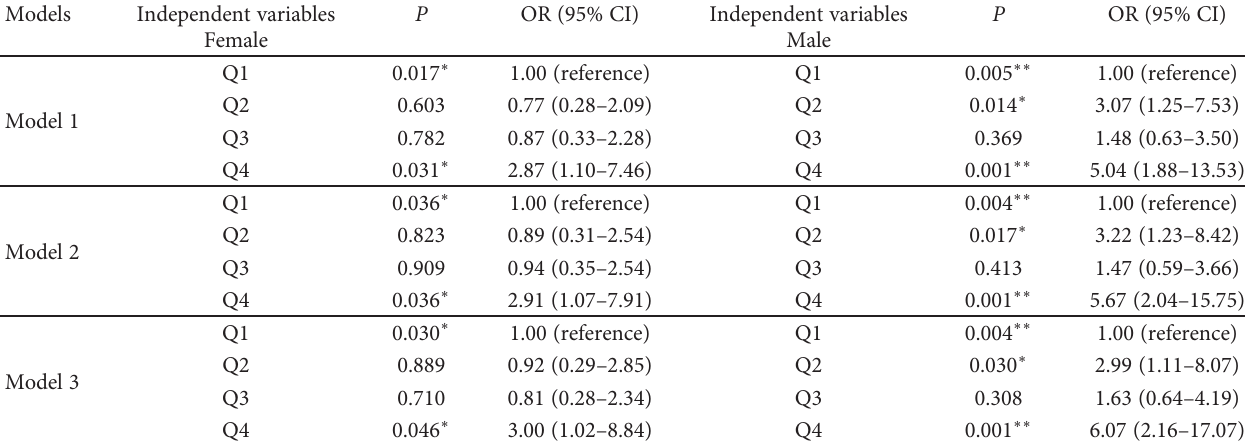
Table 3: Odds ratios (ORs) and 95% con fi dence intervals (CI) for AN, according to serum UA quartiles: results of binary logistic regression analysis in di ff erent